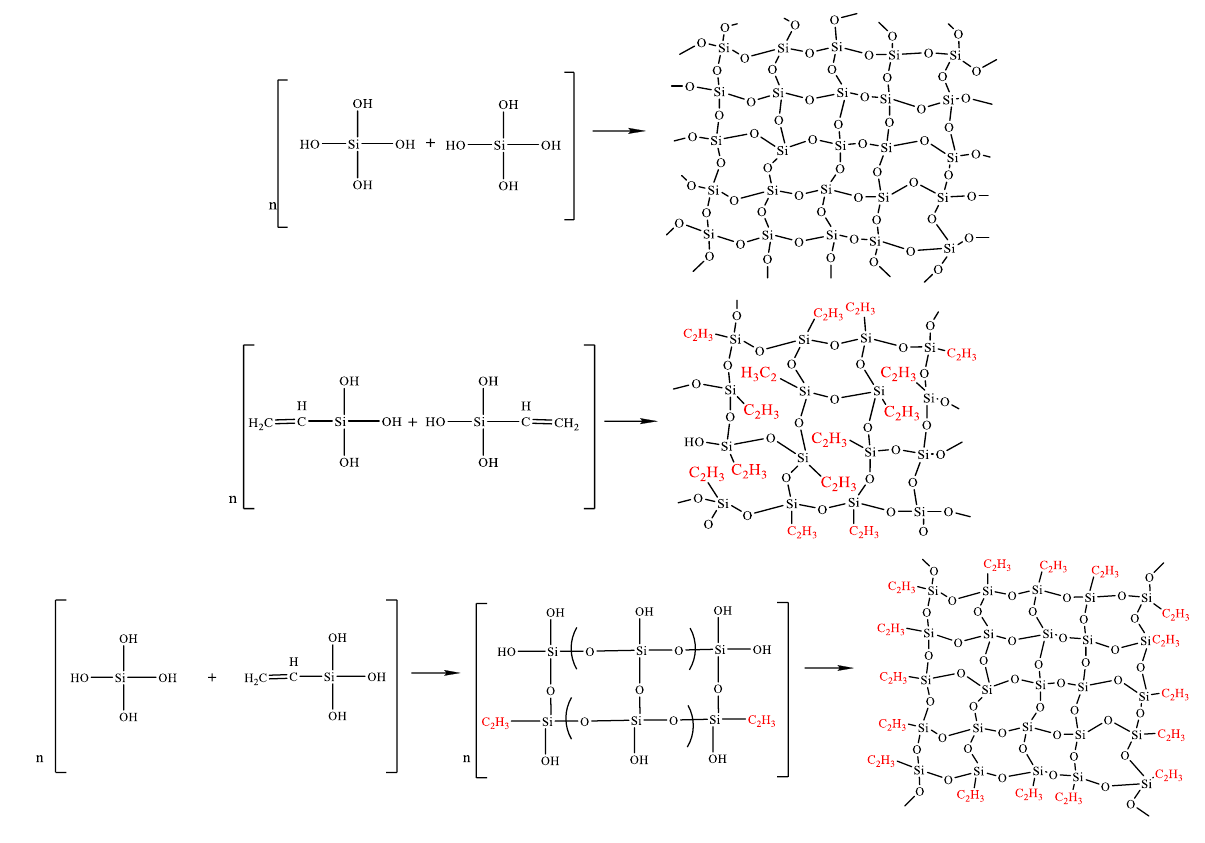
Figure 11. Mechanism of the condensation reactions.